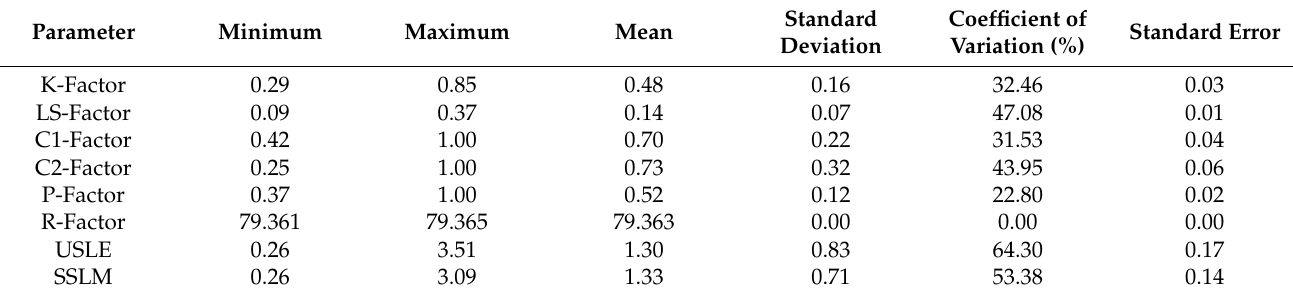
Table 11. Descriptive data on the rates of USLE factors, the USLE model, and SSLM.